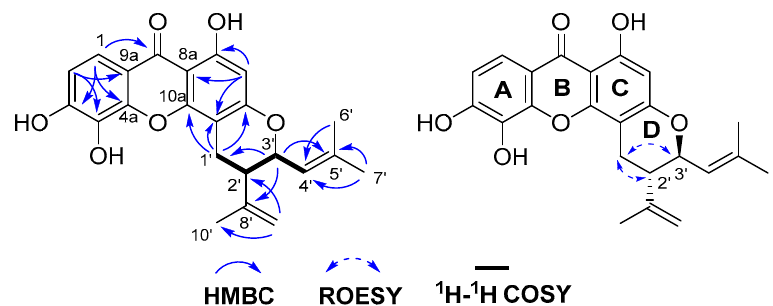
Molecules 2019 , 24 , 3568 Figure 2. Key 1 H– 1 H COSY, HMBC and ROESY correlations of hypxanthone B. Figure 2. Key 1 H– 1 H COSY, HMBC and ROESY correlations of hypxanthone B.